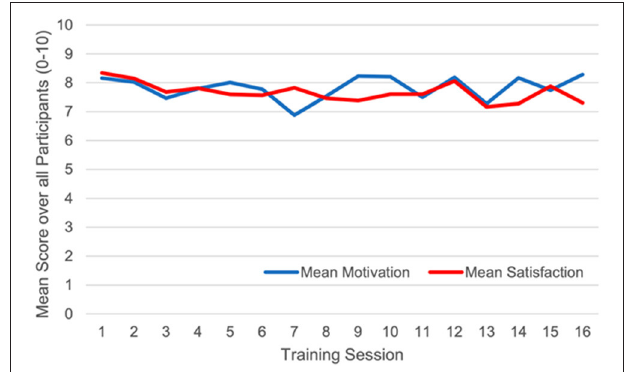
FIGURE 5 | Mean motivation and satisfaction ratings over all